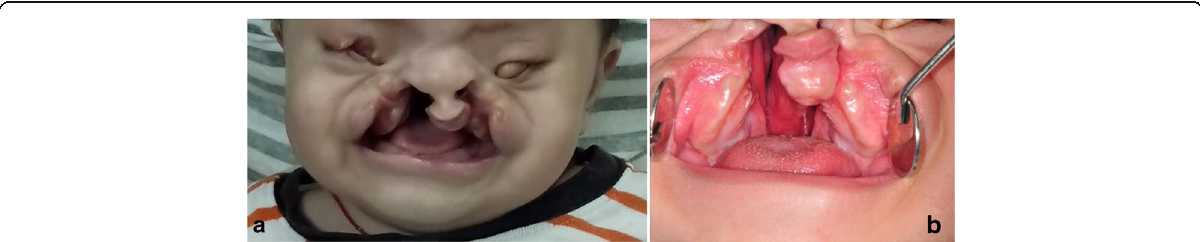
Fig. 1 Preoperative clinical photographs. a An 8-month-old boy showed bilateral oronaso-ocular clefts with right-sided microphthalmia and left-sided clinical anophthalmia. b Intraorally, bilateral severe alveolar clefts and complete palatal cleft were